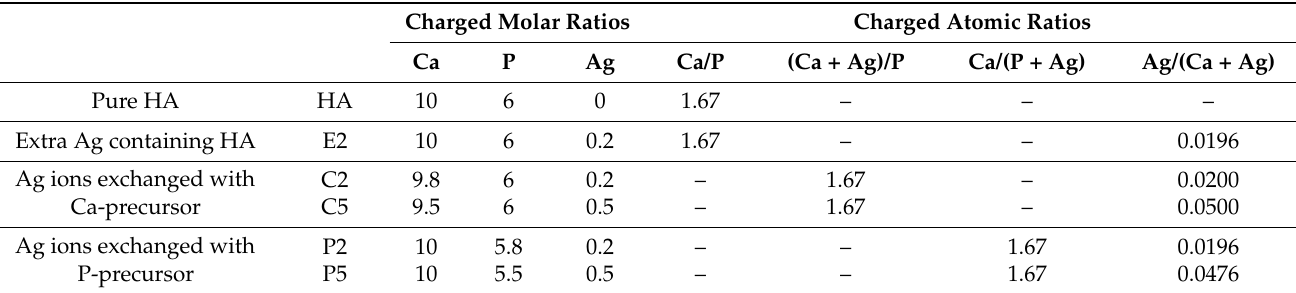
Table 1. The charged composition and atomic ratios of the Ag-HA series of interest to the present study. Charged Molar Ratios Charged Atomic Ratios